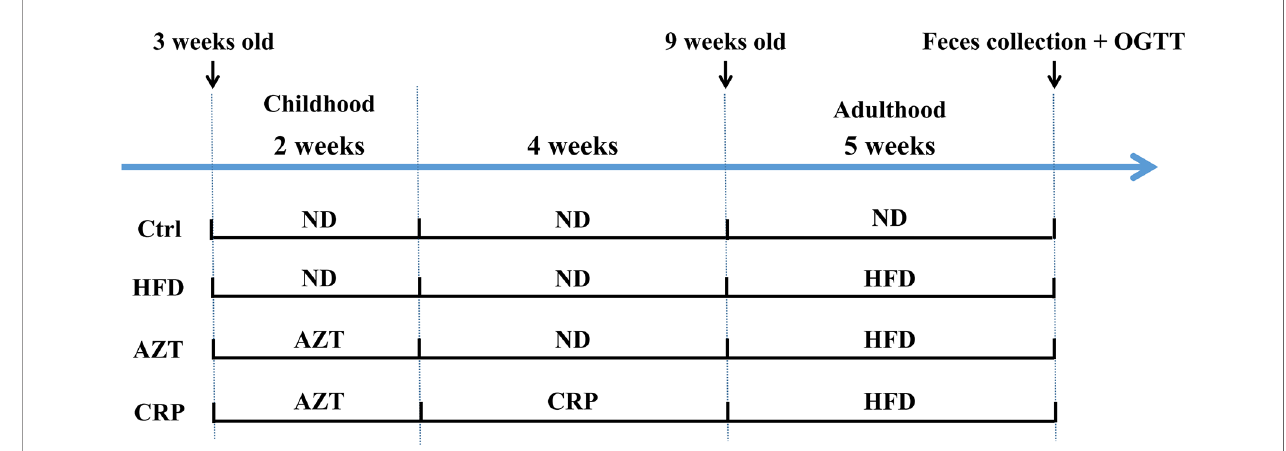
FIGURE 1 | The experimental fl ow chart. Forty three-week-old mice were treated with or without AZT in drinking water for two weeks and were subsequently fed with or without a CRP diet for four weeks and then an ND or HFD for another fi ve